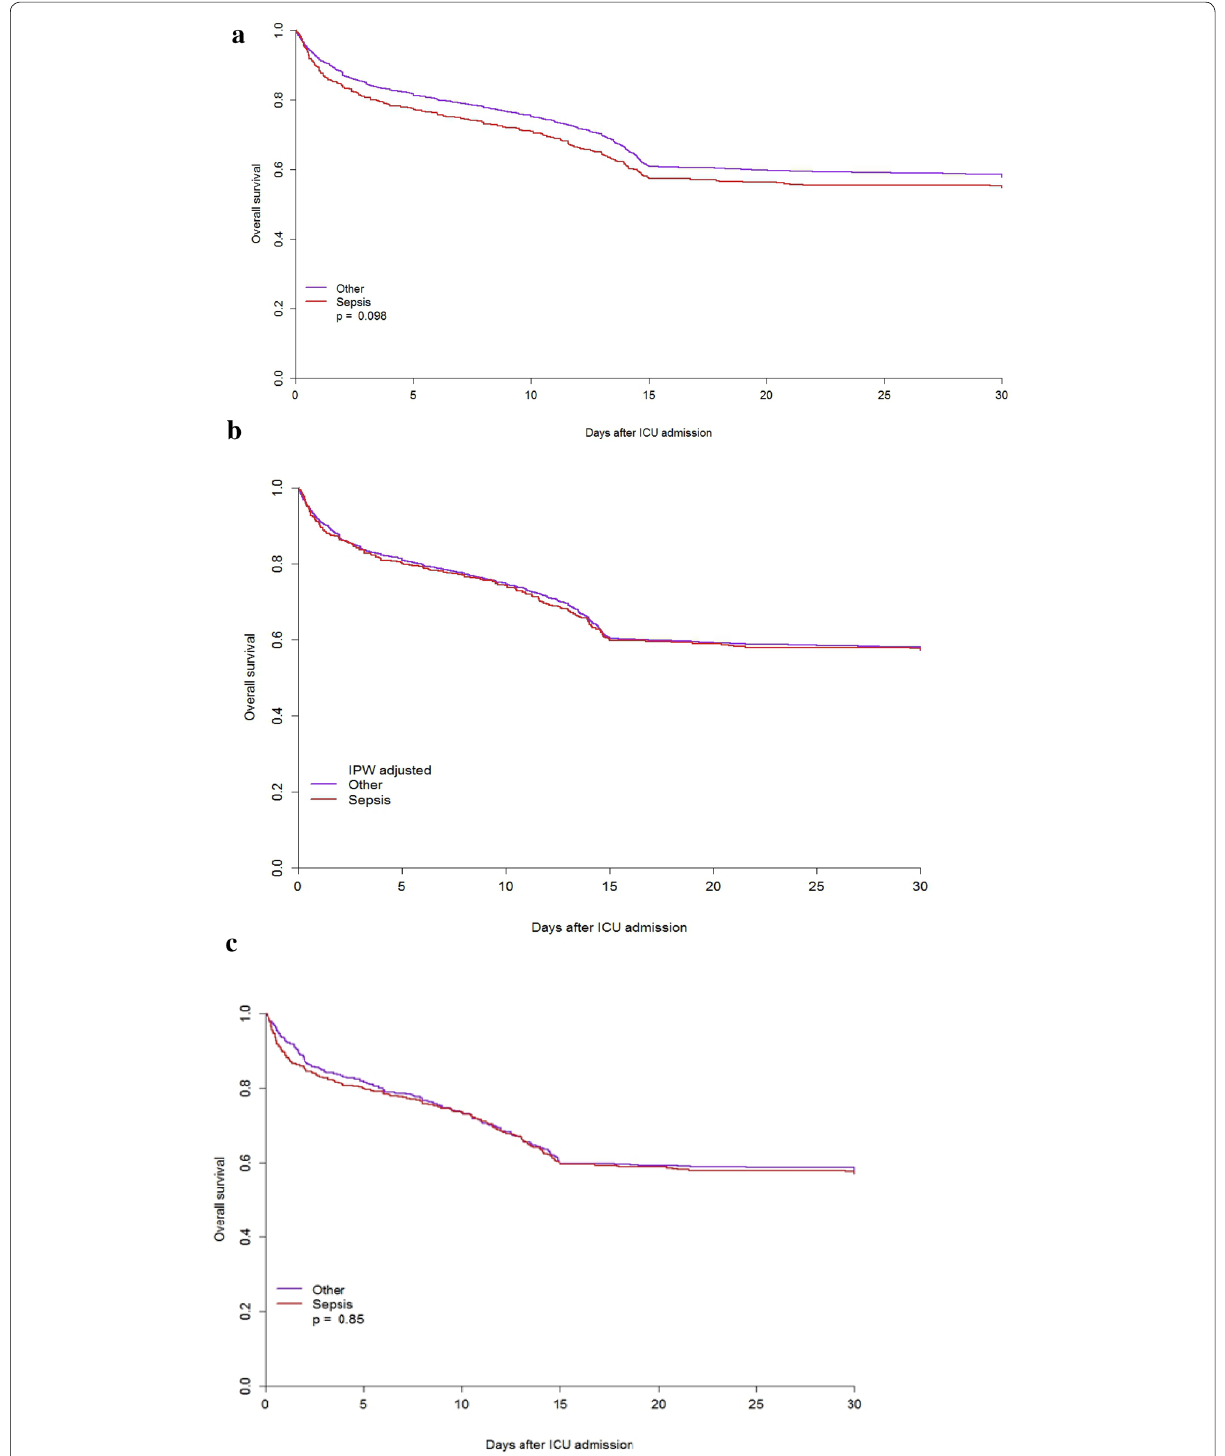
Fig. 2 Kaplan–Meyer survival curves in septic and acute non-septic patients. a Non-adjusted. b Inverse-probability weight (IPW)-adjusted overall survival (the weights were estimated using frailty, age, gender, type of admission, and SOFA score). c Matched cohort survival